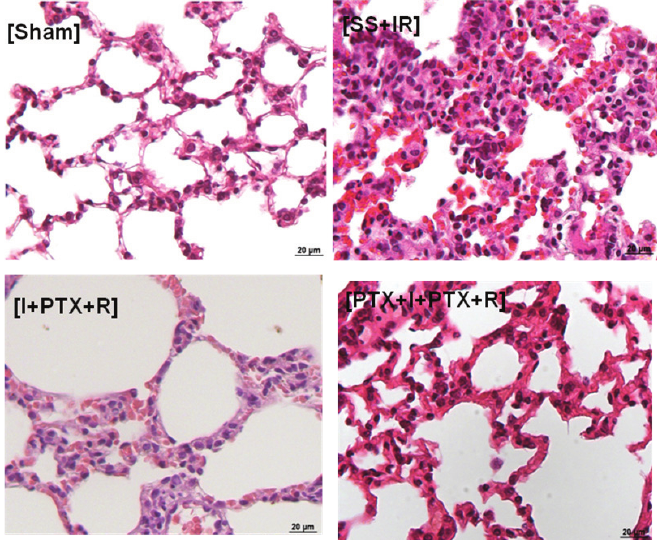
FIGURE 5 - Histological lung sections of lungs from sham-operated rats [Sham] show a normal pulmonary architecture. In the group SS+IR it can be seen massive alveolar congestion and neutrophil infiltration. In the groups treated with pentoxifylline, ([I+PTX+R] and [PTX+I+PTX+R]) the interstitial congestion was minimal, and the leukocyte (neutrophil) infiltration was strongly reduced. Hematoxylin and eosin staining. Scale bar: 20 µm. (H.E -